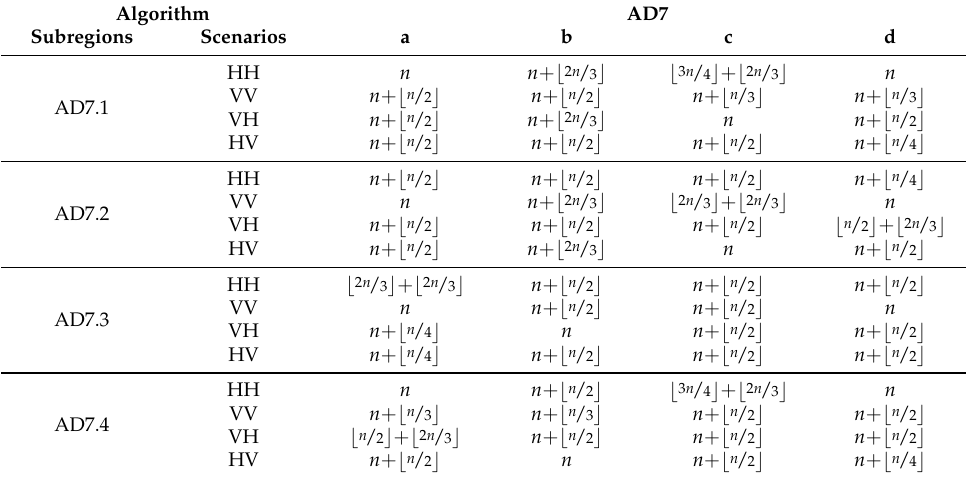
Table 3. Algorithm AD7